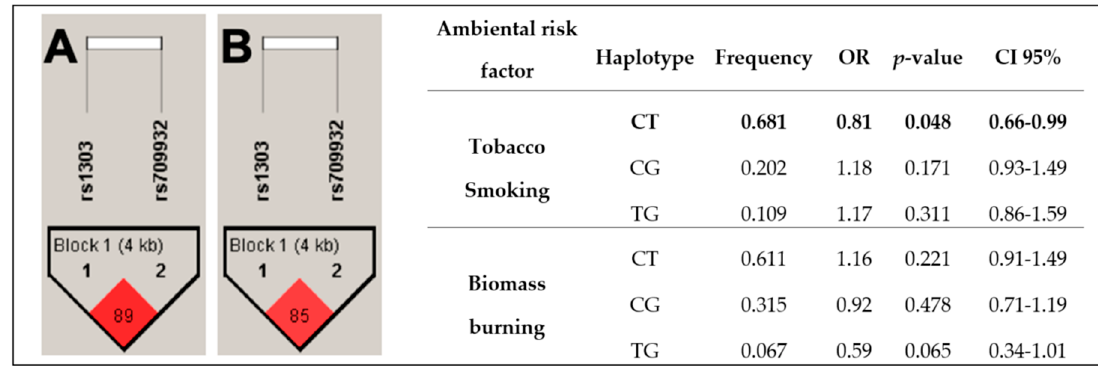
Figure 1. Haplotype analysis: Two SNPs were evaluated in both comparisons; among tobacco-smoking groups, the CT haplotype was identified associated with reduced risk. Panel A = COPD-S vs. SWOC; Panel B = COPD-BB vs. BBES. p -value < 0.05 was considered significative.